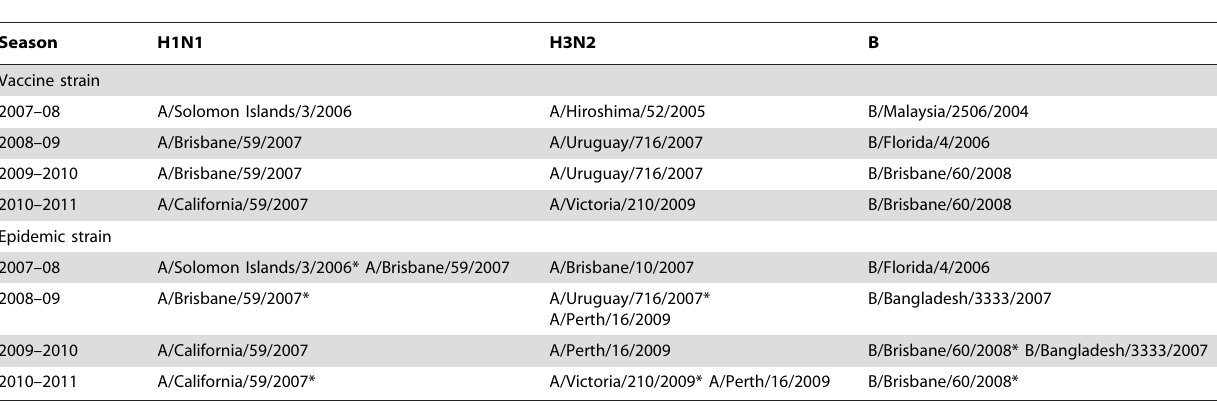
Table 1. Vaccine and epidemic strains 2007–2011.